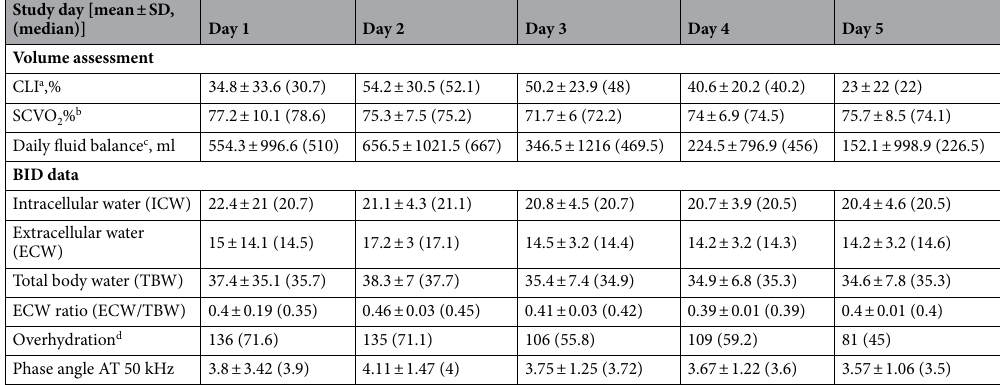
Table 2. Outcome of volume assessment and BID exam of study population during first 5 days after surgery. a Capillary leak index was defined as C-reactive protein (CRP) over serum albumin ratio which was multiplied by 100, as described in Malbrain et al. 11 . b Central venous oxygen saturation (SCVO 2 ) was measured via indwelling central line of the patients. c Daily fluid balance was defined as the difference between daily total intake including both intravenous and enteral fluid administered, blood products or medications and total output including all losses through urinary, gastrointestinal, or other drainage tubes. d Overhydration is defined as the case where the value of ECW ratio (ECW/TBW) is above 0.390 13–15 .